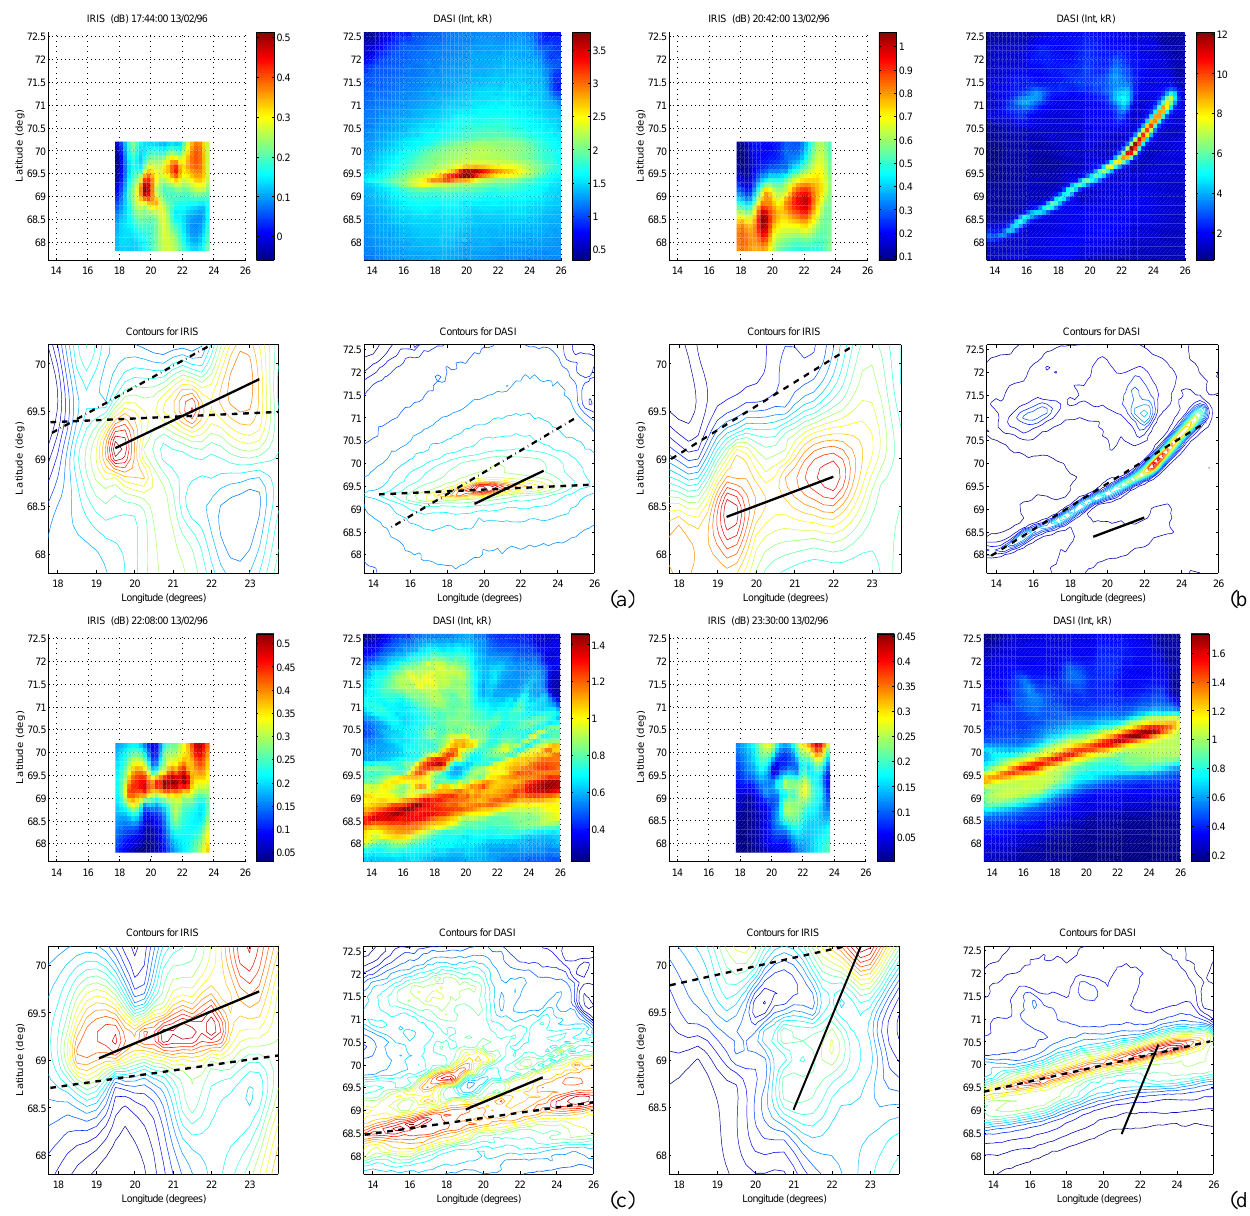
Fig. 5. Auroral forms as seen by IRIS and DASI in their respective fields of view on 13 February 1996. The colour scales are in dB for IRIS, and in kR for DASI. The bottom panels show the contour plots corresponding with the top 2-D images. The estimated extent and alignment of the absorption region and the optical feature is given, respectively, by the full and the dashed lines. (a) Arc feature in the evening sector at 17:44UT/20:20MLT, the dot-dashed line defines the sharper edge of the absorption/higher energy precipitation region north of the optical signature. (b) Post-Harang discontinuity arc at 20:42UT/23:20MLT during expansion phase. (c) Early morning precipitation during substorm recovery at 22:00UT/00:30MLT. (d) Morning arc at 23:30UT (02:00MLT) during substorm growth phase.